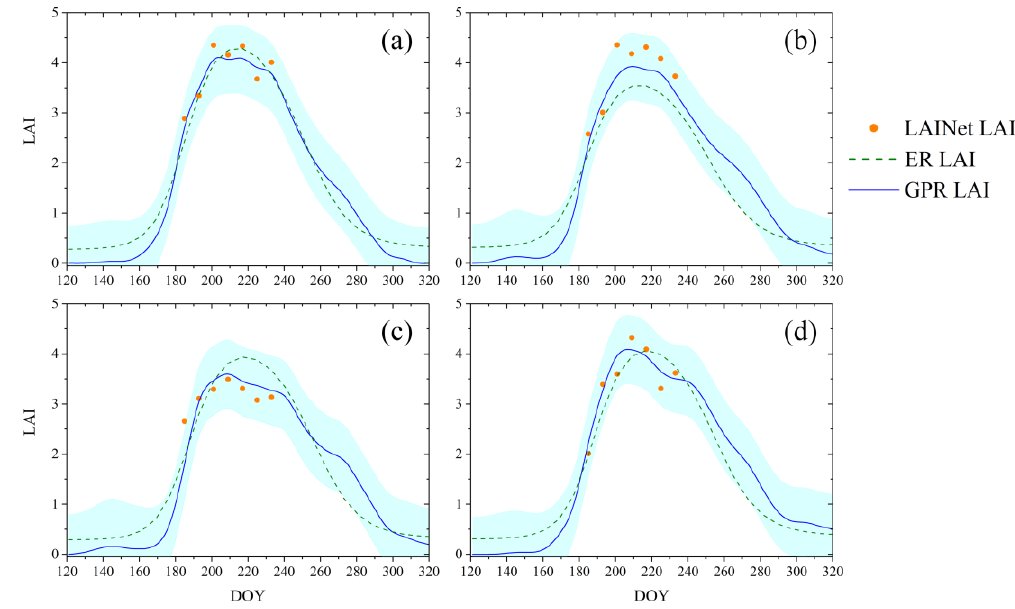
Figure 9. The temporal evolution of the LAI derived from Gaussian process regression (GPR), exponential regression (ER), and LAINet field observations for ( a ) node 3, ( b ) node 5, ( c ) node 8, and ( d ) node 12 (see Figure 1 for node location). The shaded areas represent the GPR uncertainty.